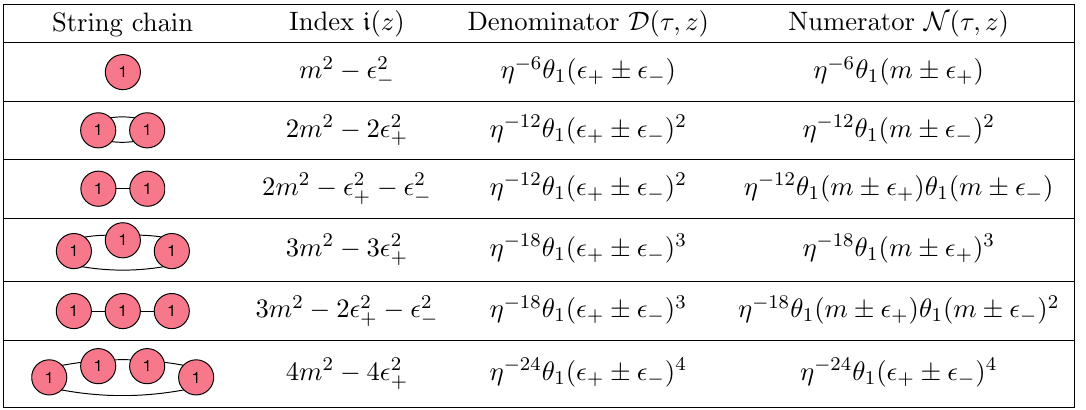
Table 1 . Elliptic genera of (2 ; 0) string chains determined from I 0